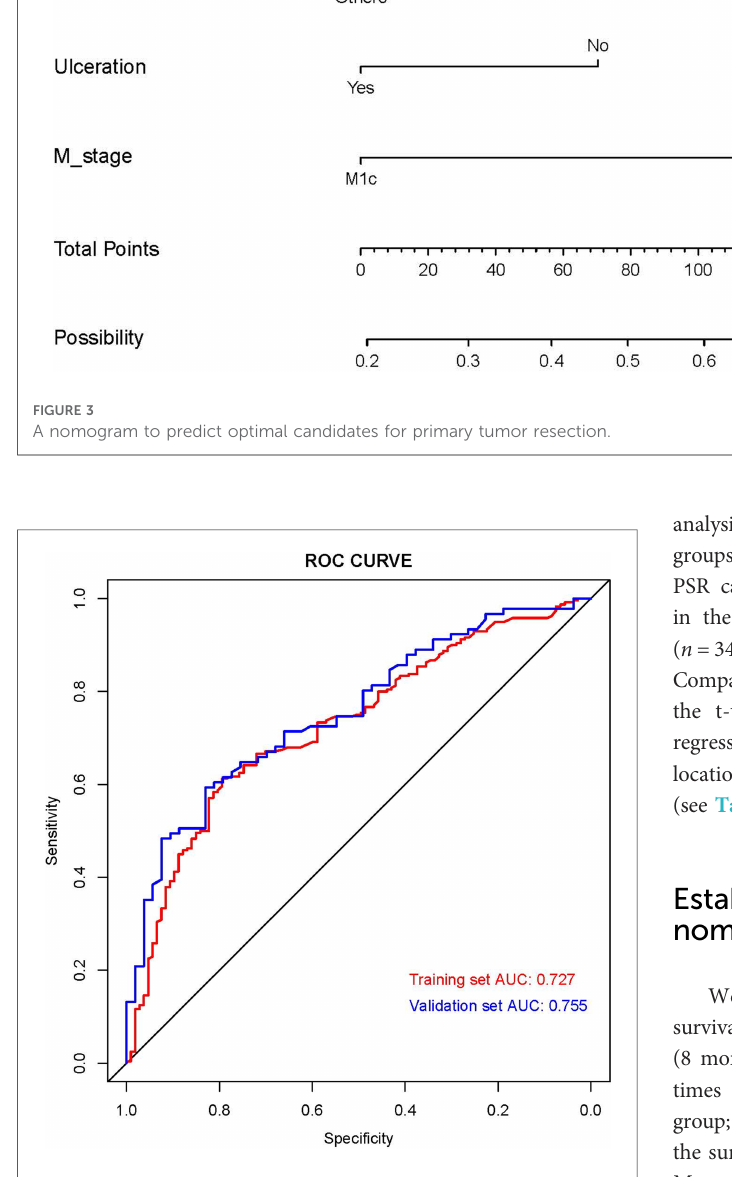
FIGURE 4 ROC curves of the nomogram. ROC curves of the nomogram in the training set (Red) and validation (Blue). ROC, receiver operating